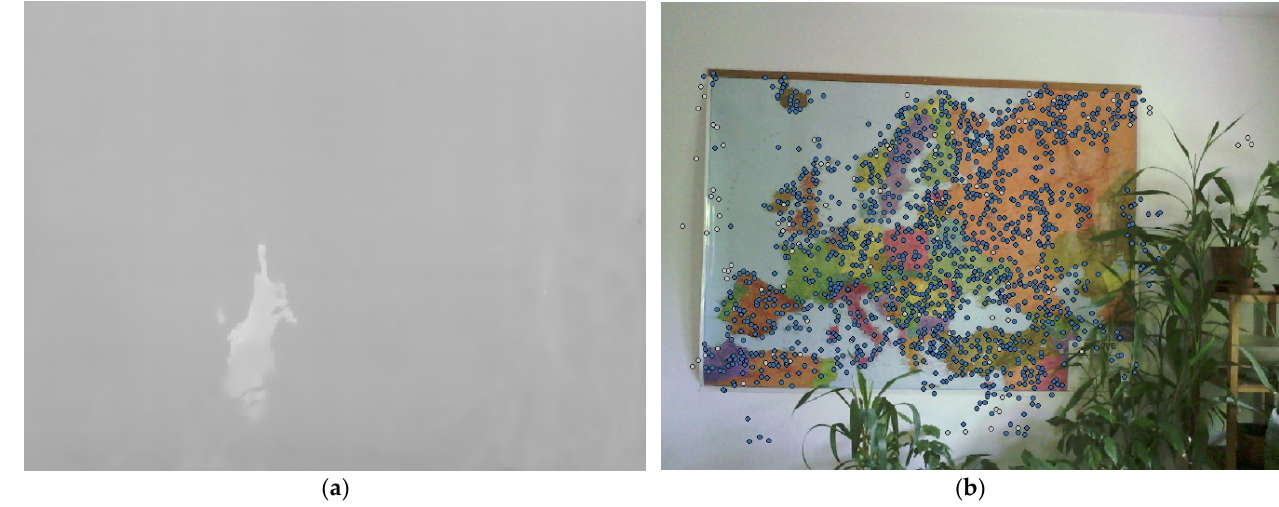
Figure 1. TIR and RGB image of the same scene: ( a ) feature matching algorithm failed to find any key point or tie point; ( b ) feature matching algorithm found sufficient amount of tie points (blue dots).